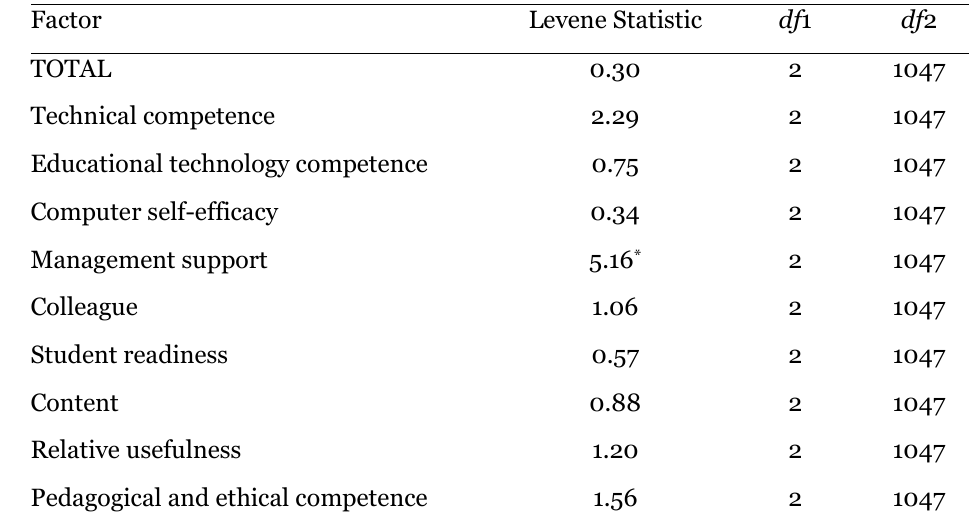
Tests of Homogeneity of Variances